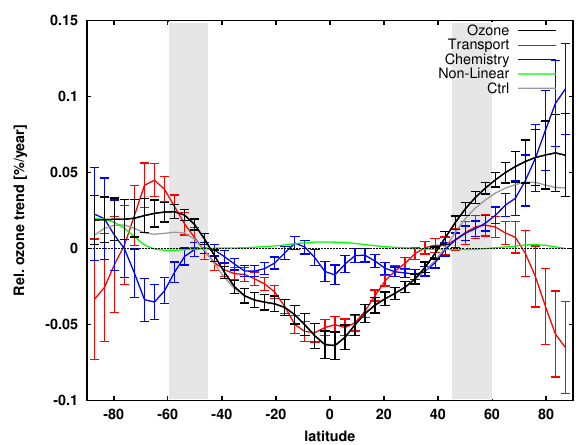
Fig. 9. Trend regression coefficients as a function of latitude for NIWA-SOCOL of lower stratospheric partial column ozone (black), transport-induced ozone trends (red) and chemically-induced ozone trends (blue). The green line line is the nonlinear contribution to ozone trends, and the grey line is the control line (sum of chem- istry, transport and nonlinear term). Light grey bars indicate the mid-latitude averaging region used in this